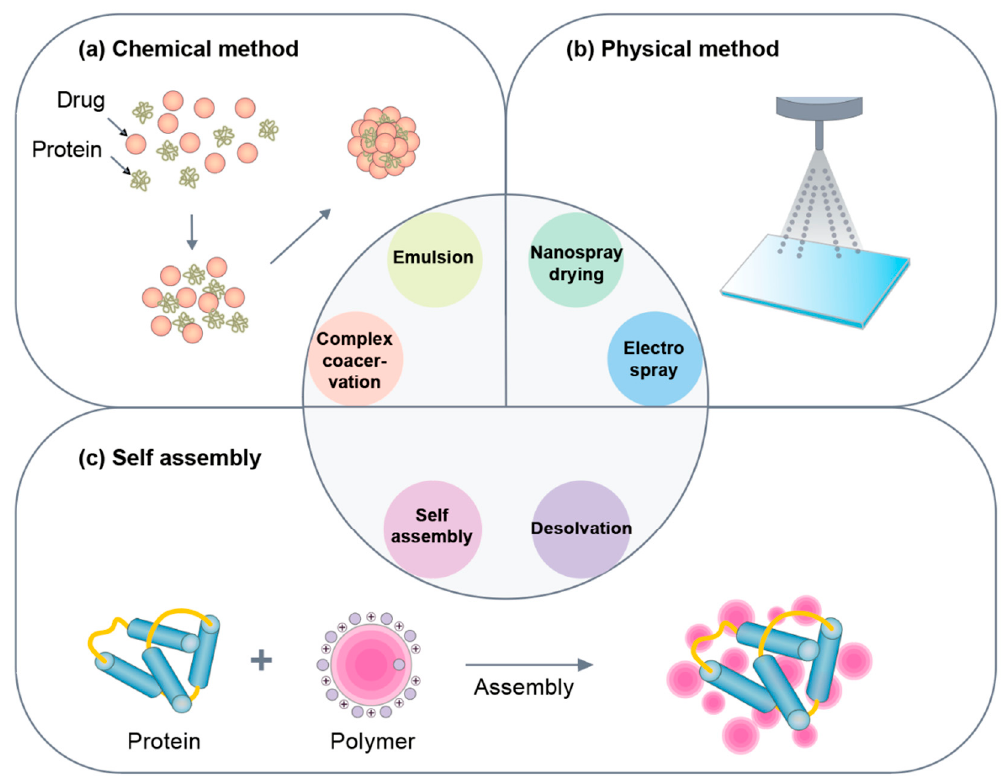
Figure 2. Categorization of methods for preparing protein nanoparticles. ( a ) The chemical method produces protein nanoparticles using a chemical reaction and includes emulsion and complex coacervation. ( b ) The physical method includes physically aggregating after separating proteins into nanosized particles and includes an electrospray technique and a nano spray drying method. ( c ) The self-assembly method is a method of making nanoparticles by agglutinating proteins by themselves and it includes the desolvation method. Table 2. Advantages and disadvantages of each protein nanoparticle generation methods.